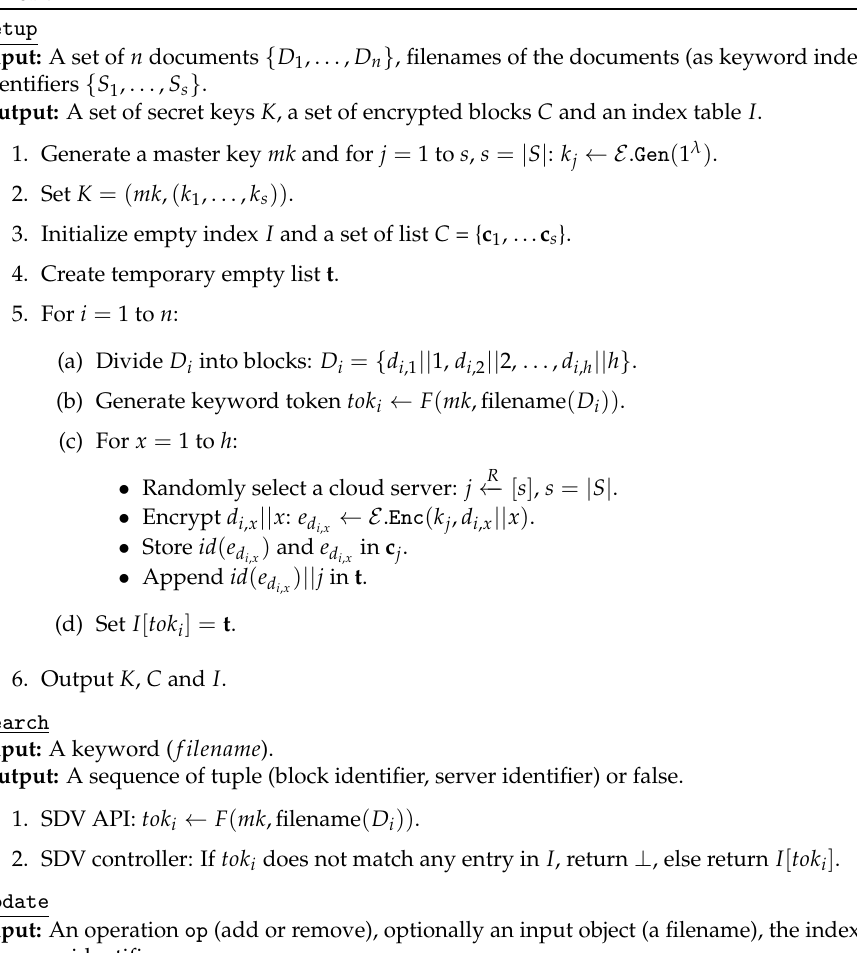
Figure 3. SSE SDV : Description of the